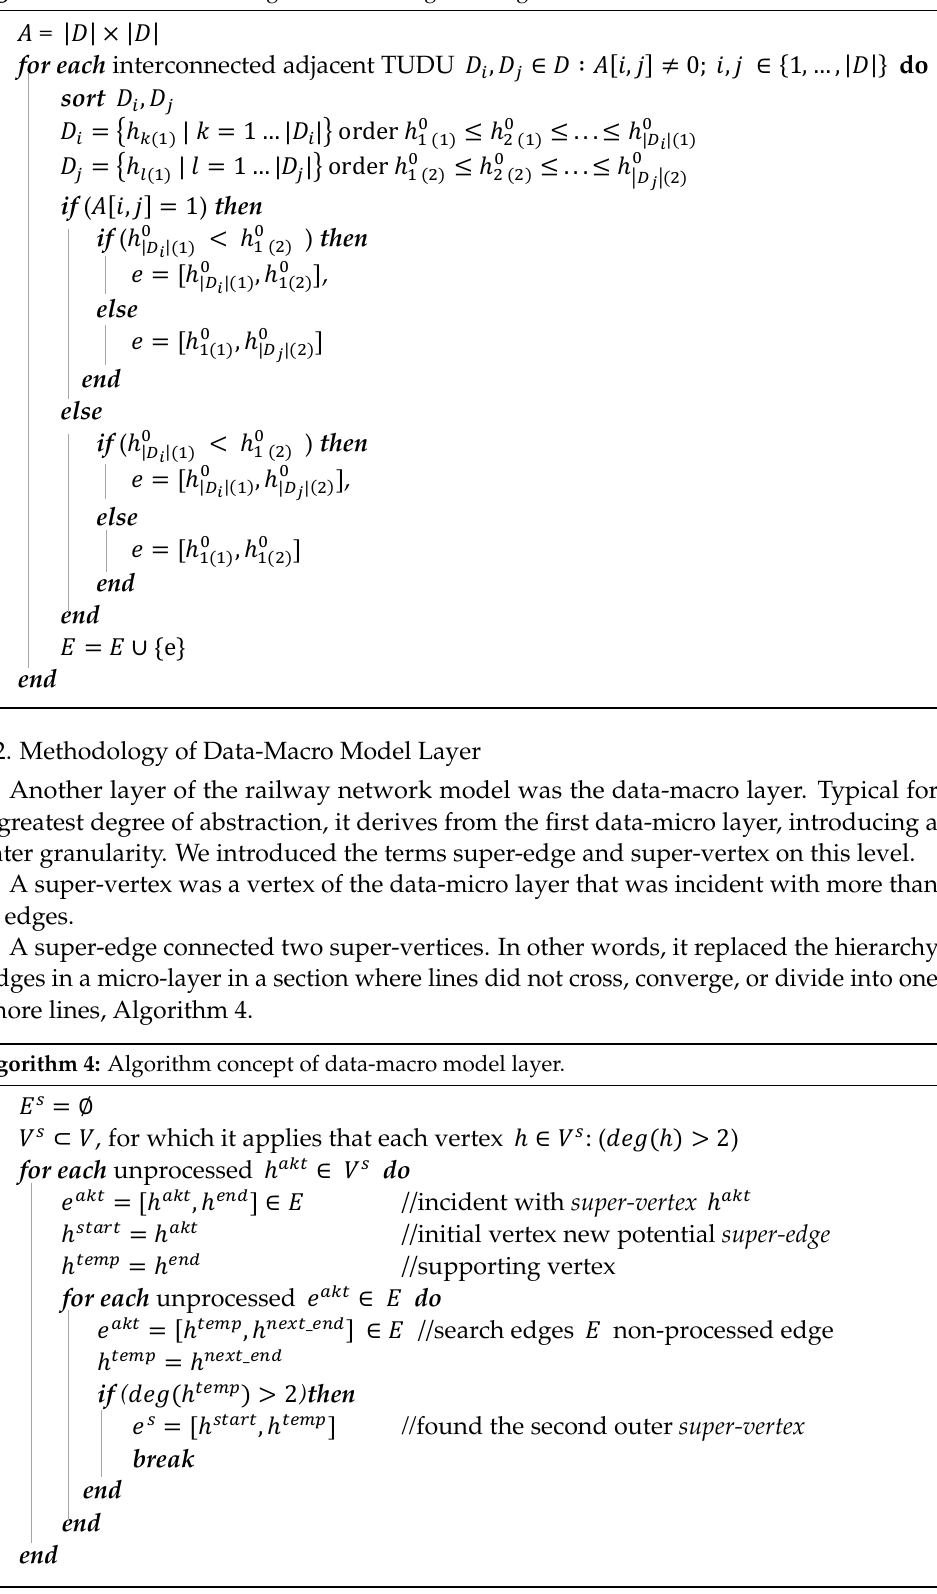
Figure 10. Sample formation of super-edges. 3.2.3. Methodology of Data-Meso Model Layer Construction An evaluation of the edges in the first data layer (data-micro) corresponded with lengths of 100 m, while in the second data layer with a higher degree of abstraction (data- macro), the edge evaluations reflected distances of several tens of kilometers. Both the data layers (data-micro and data-macro) did not directly involve railway stations as their vertices, e.g., the determination as to whether a rail vehicle is or is not at the station, or the use of the distance from the station as an alternative solution (by means of station-relating TUDU identification). This fact took into consideration the third data layer (data-meso) by means of individual super-edge decomposition, Algorithm 5. The above-mentioned data layers (data-micro and data-macro) used the same data- base for the vertices (hectometer posts), while another vertex type was integrated in the